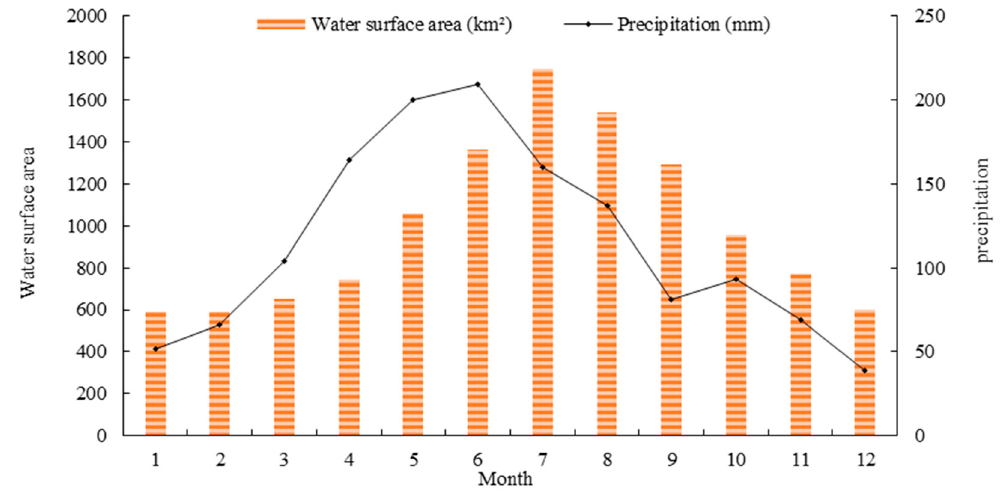
Figure 17. Comparison between the monthly water area and monthly average rainfall in Dongting Lake from 2001–2017.